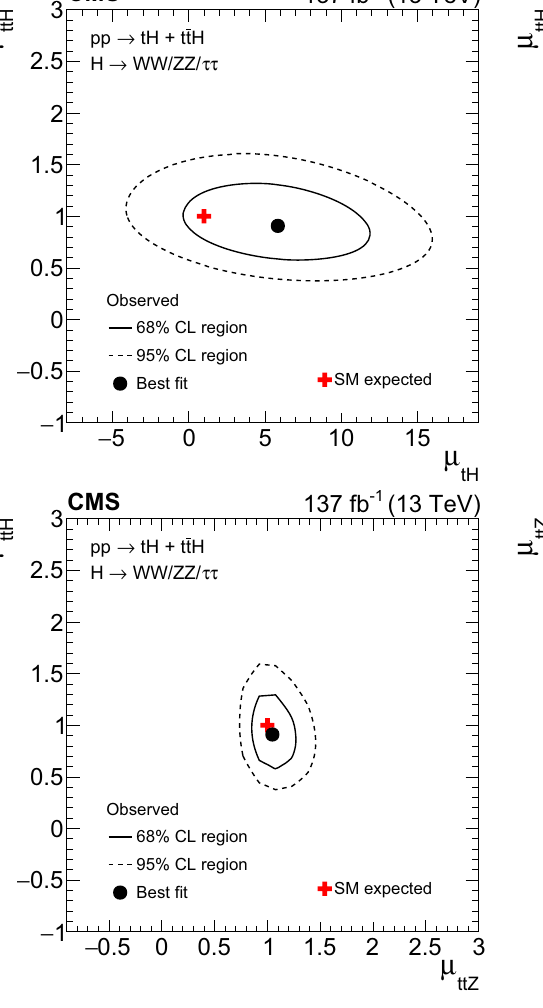
The two production rates that are not shown on either the x or the y axis are profiled such that the function L attains its minimum at each point in the x - y